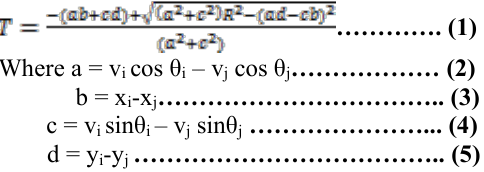
Figure 1. Path Traced by Mobile Nodes in Random Waypoint